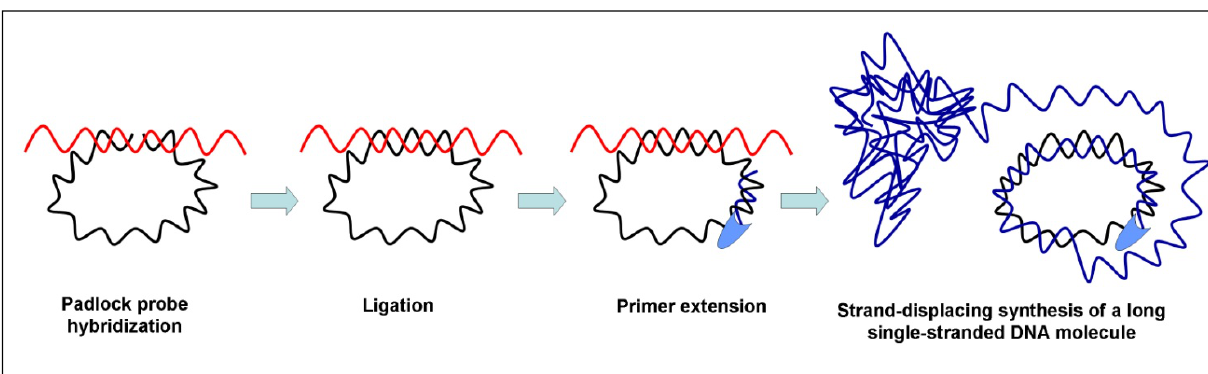
Figure 3. Principal mechanism for rolling circle amplification